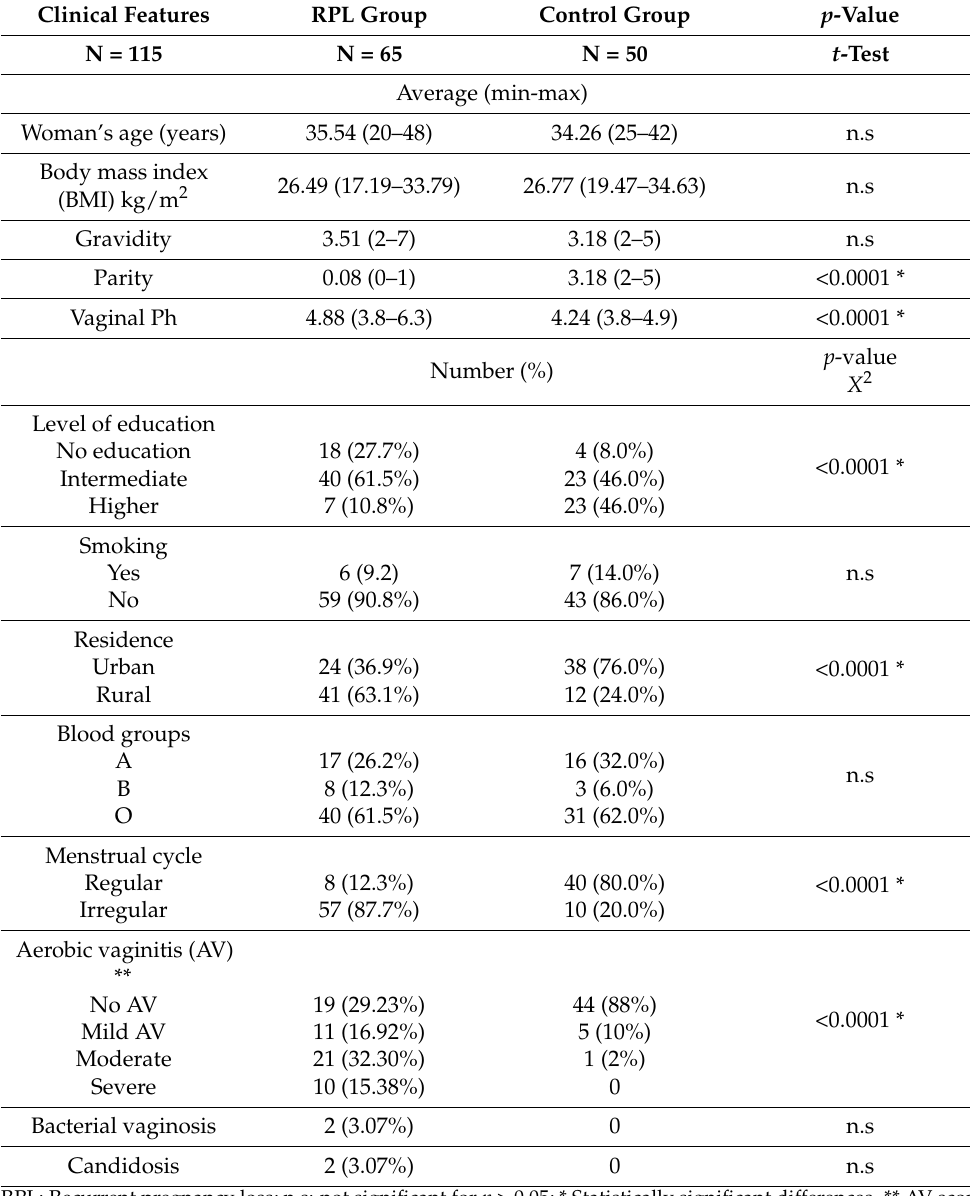
Table 2. Sociodemographic and clinical characteristics of study population and microscopic diagnosis of vaginal